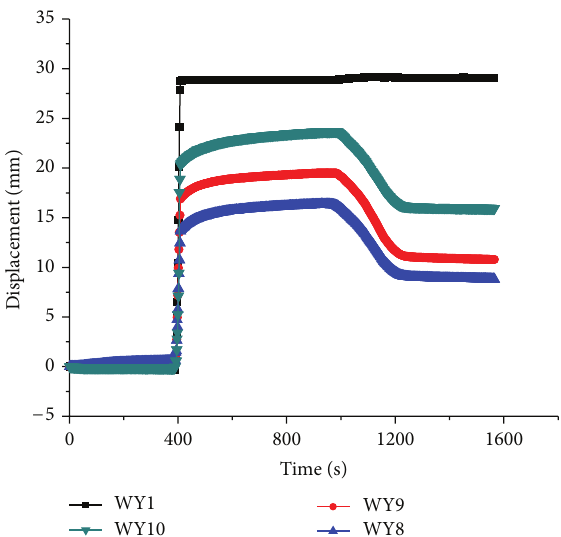
Figure 9: The displacement on top of layer number 5.